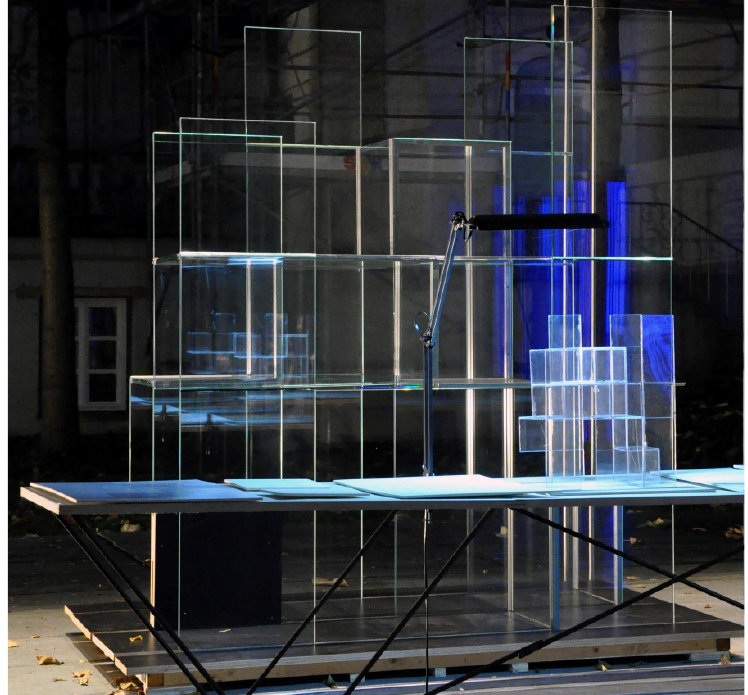
Fig. 10: Exhibition of the final structure at the Bavarian Chamber of Architects BYAK in